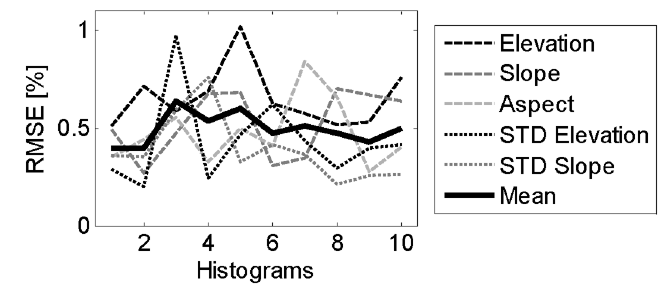
Figure 5. RMSE of the histograms of the ten extracted possible training sets from terrain aspect data.